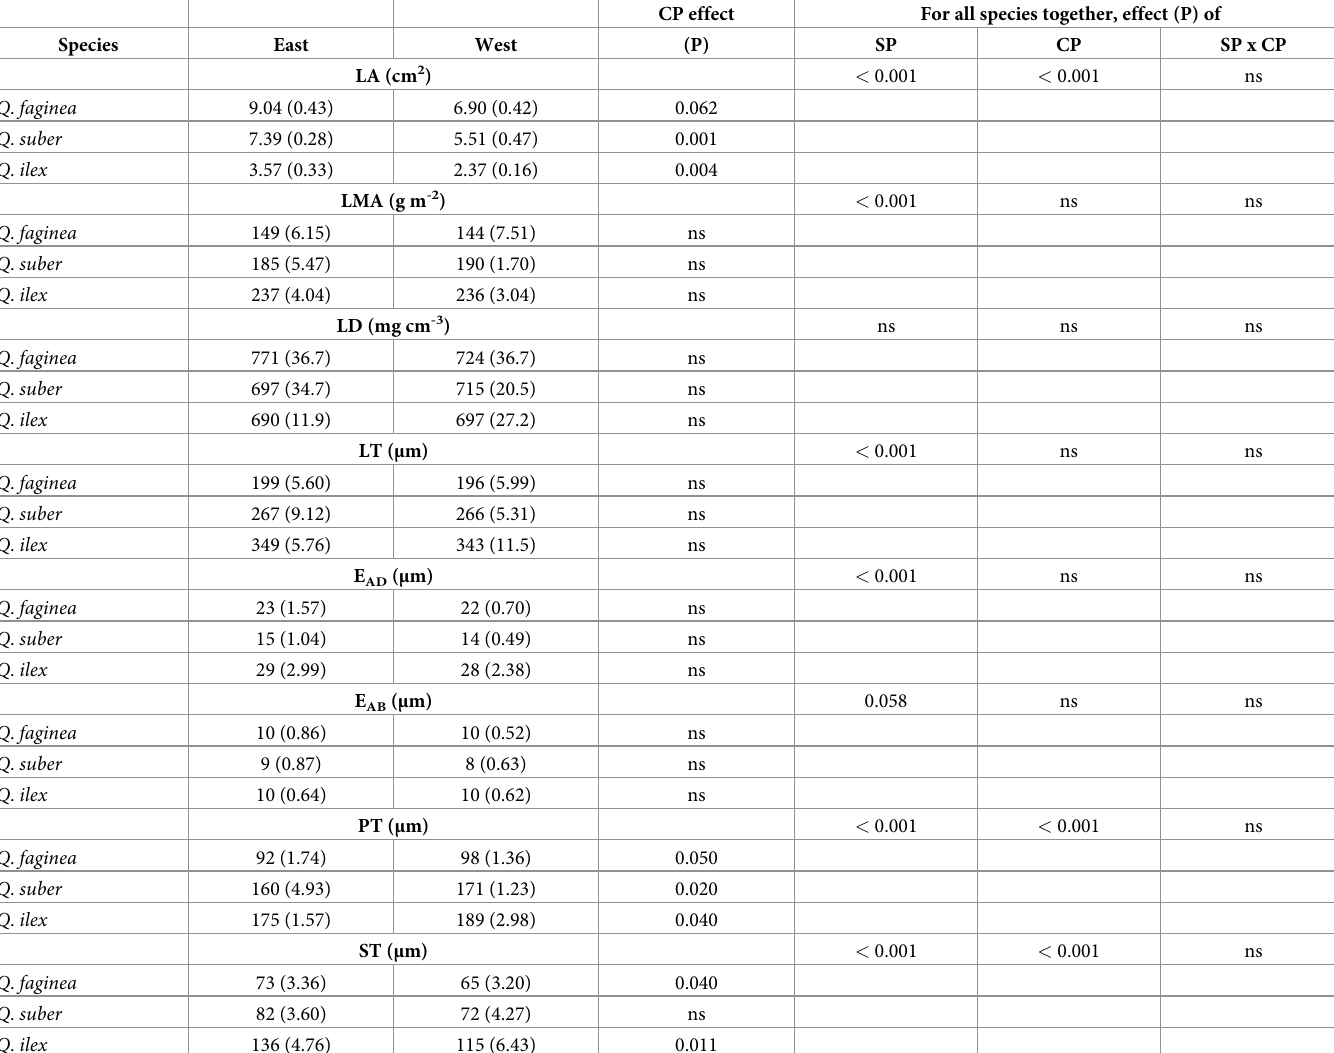
Table 2. Average leaf morphological traits at two canopy orientations (S.E. in parentheses, n = 5 trees) for three tree species. Results of analyses of variance for indi- vidual species in tests for effect of canopy position (CP) and for all species together in tests for species differences (SP), effect of canopy position (CP) and species x canopy position (SP x